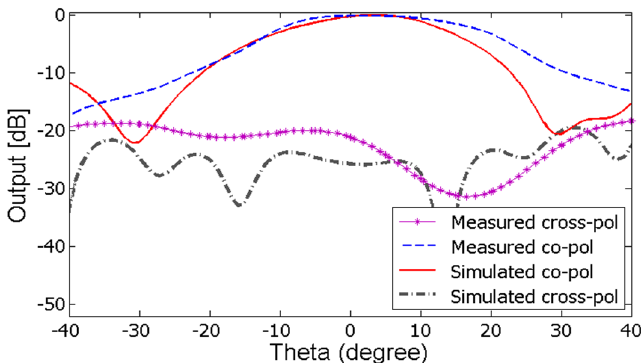
Figure 17. Co-pol and cross pol of the beam steering antenna system when exciting port 2 and applying V 1 = V 2 = 20 V at mid-band frequency of 17 GHz.